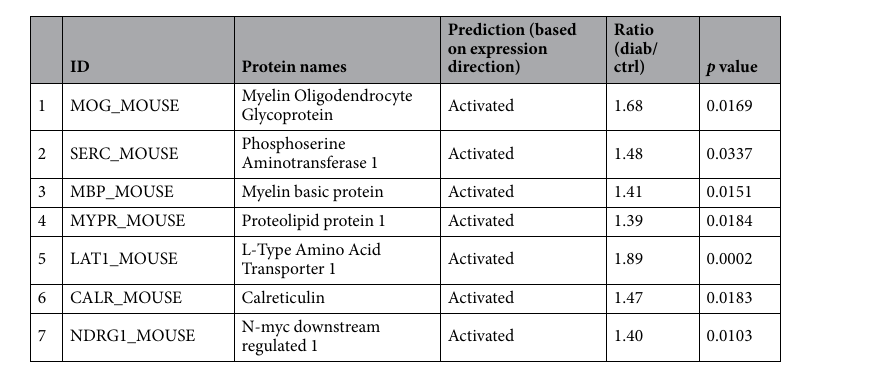
Table 3. Altered MAM proteins involved in the PERK/eIF2/ATF4